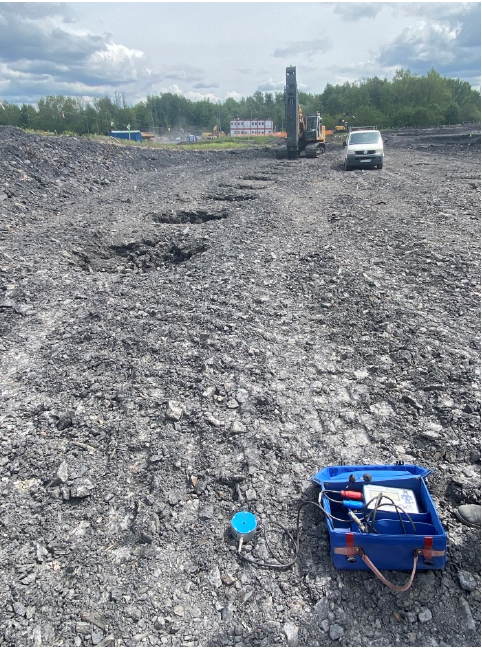
Figure 20. First stage of vibration control—safe distance from formworks (by J. Rybak).